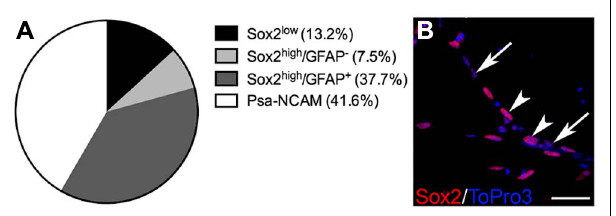
FIGURE 3 | Cell populations migrating in SVZ explant cultures. (A) Percentage of cells positive for the markers PSA-NCAM, Sox2 and GFAP, in the SVZ explant experiment. All analyzed cells migrating out from the explants expressed Sox2, in low or high levels. Similar proportions of neuronal (PSA-NCAM + ) and glial (GFAP + ) cells migrated in the SVZ explants cultures and the majority of the GFAP + cells expressed Sox2 high . (B) Examples of Sox2 low (arrows) and Sox2 high (arrowheads) cells. Scale bar in (B) = 20 μ m.